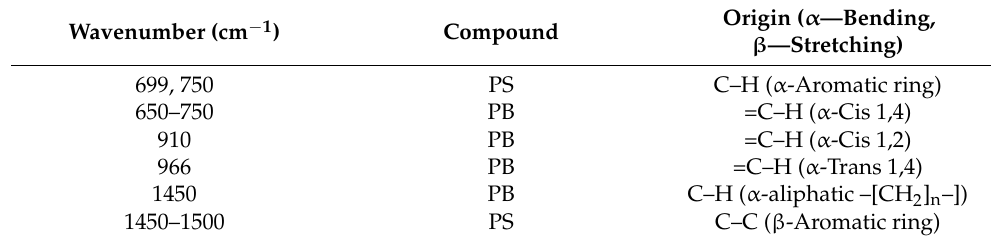
The 1 H NMR spectra of the polymers also show differences, with the signal at 5 ppm corresponding to the vinyl protons